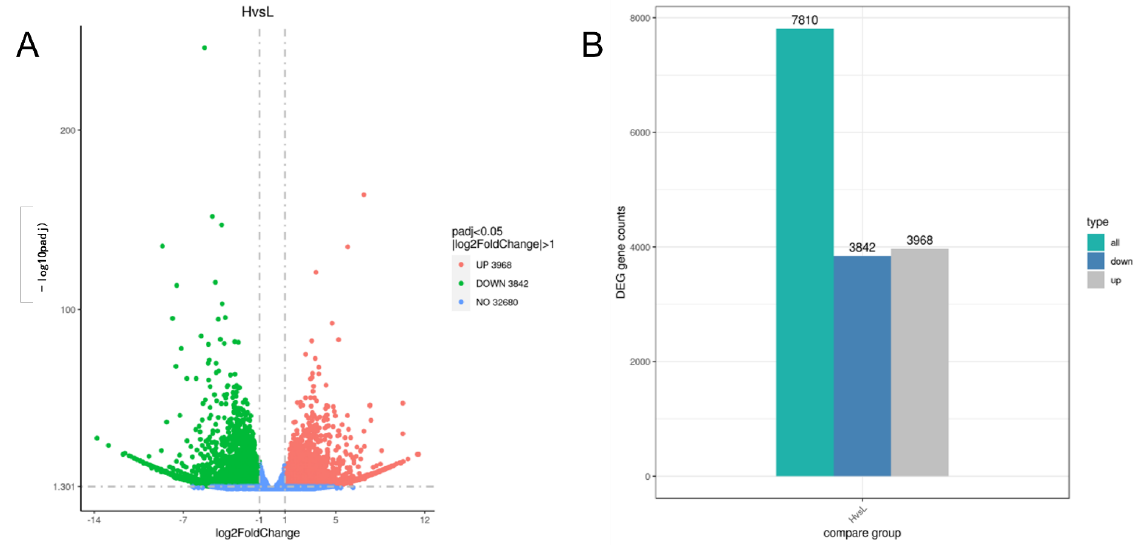
Figure 5. DEGs distribution. ( A ) DEGs volcano map. ( B ) DEGs column chart. Note: all: all the DEGs; up: upregulated DEGs; down: downregulated DEGs.